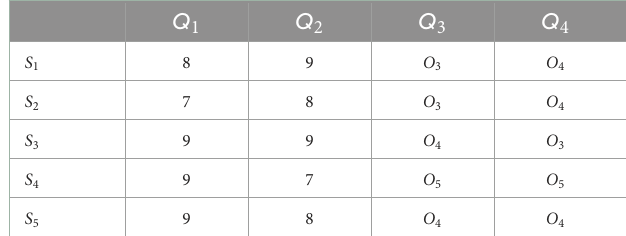
TABLE 4 Doctors’ expectations for